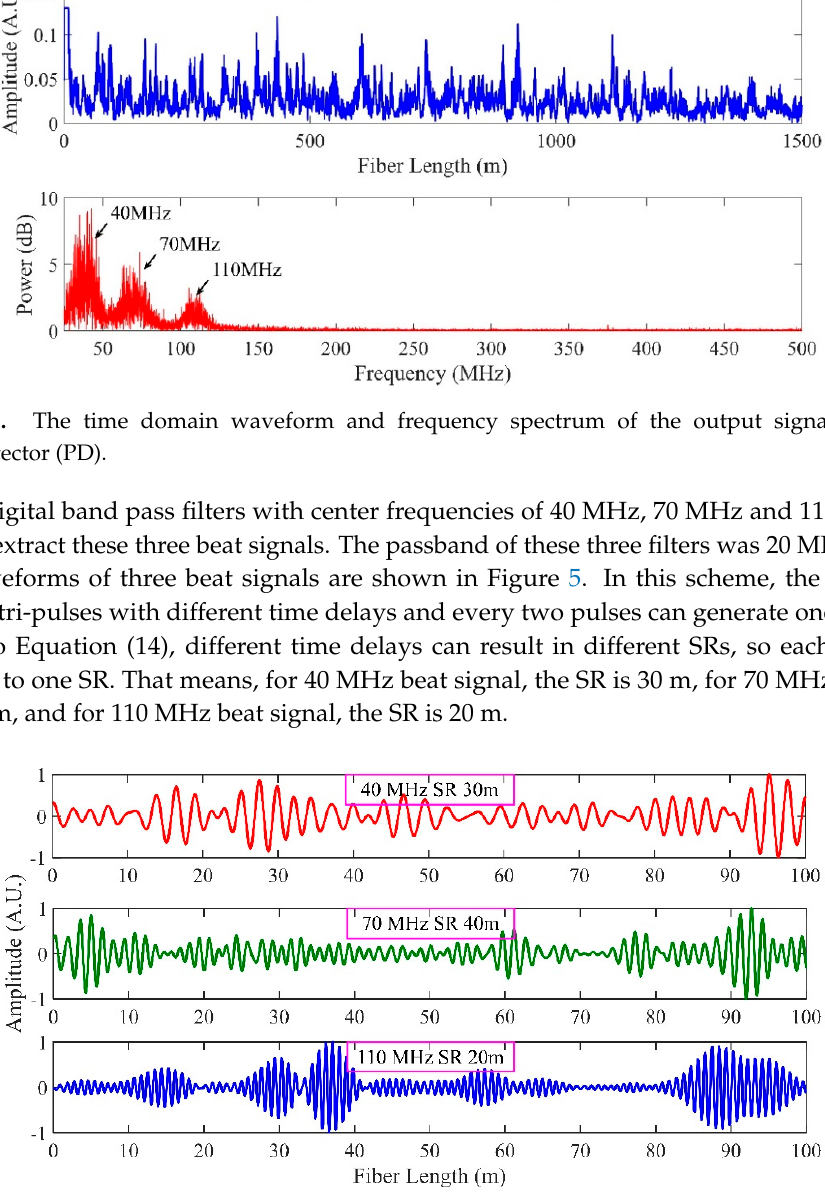
Figure 5. The time domain of three beat signals.